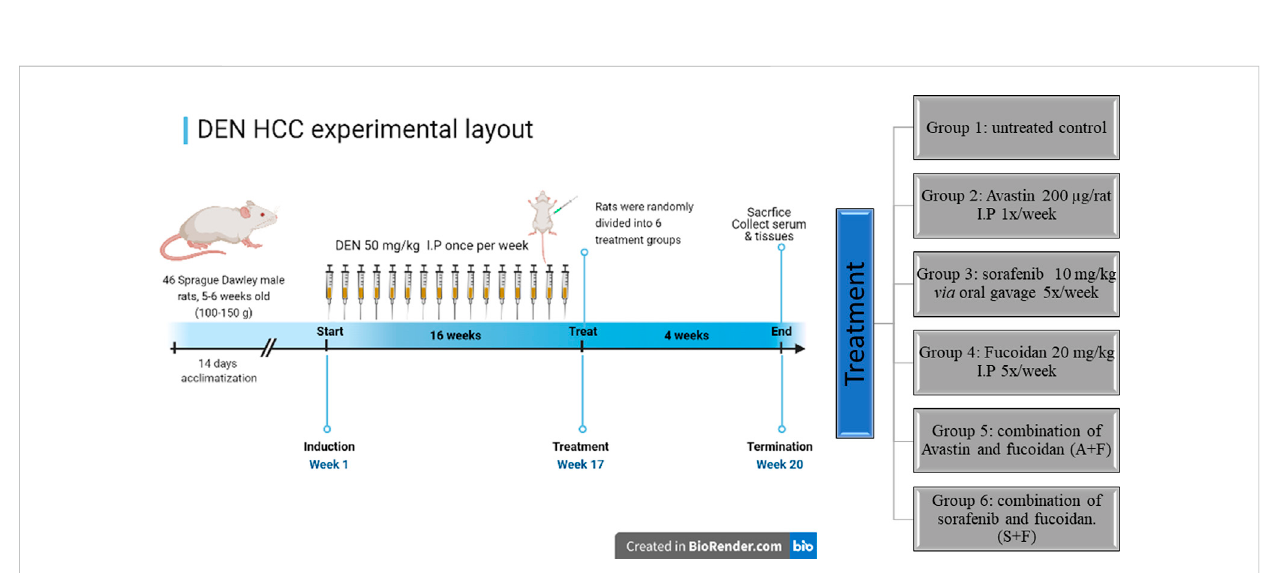
FIGURE 8 A diagram depicting the in vivo experimental timeline used to develop the DEN HCC rat model as well as the different treatment groups (created in